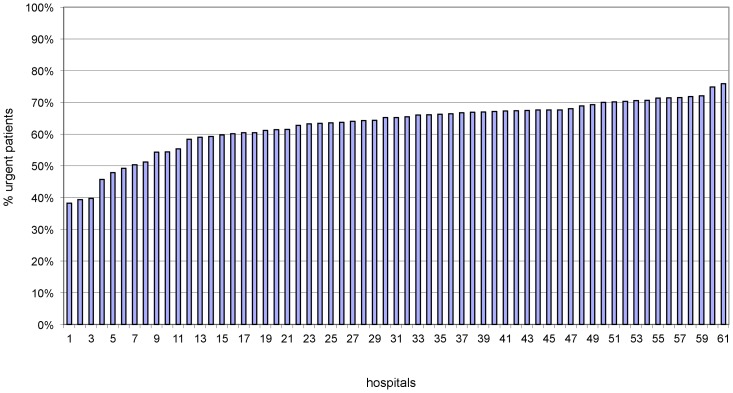
Proportion of urgently admitted patients per hospital (for the 50 CCS diagnoses used in calculating HSMR).